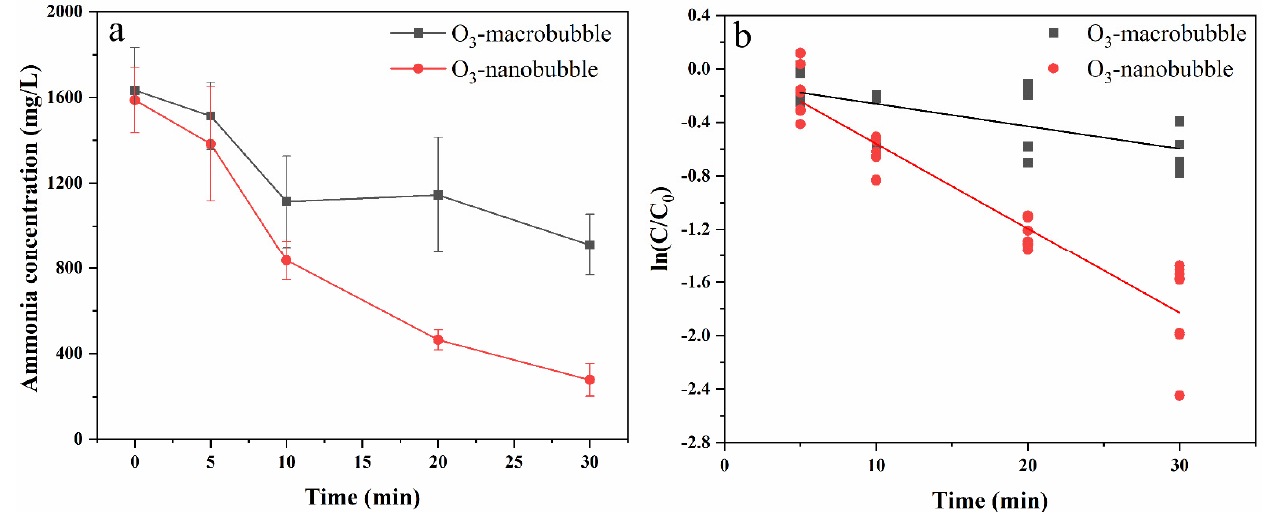
Figure 4. The concentration of ammonia remaining in the wastewater during the treatment, and the simulations of the first-order kinetics model of the ammonia